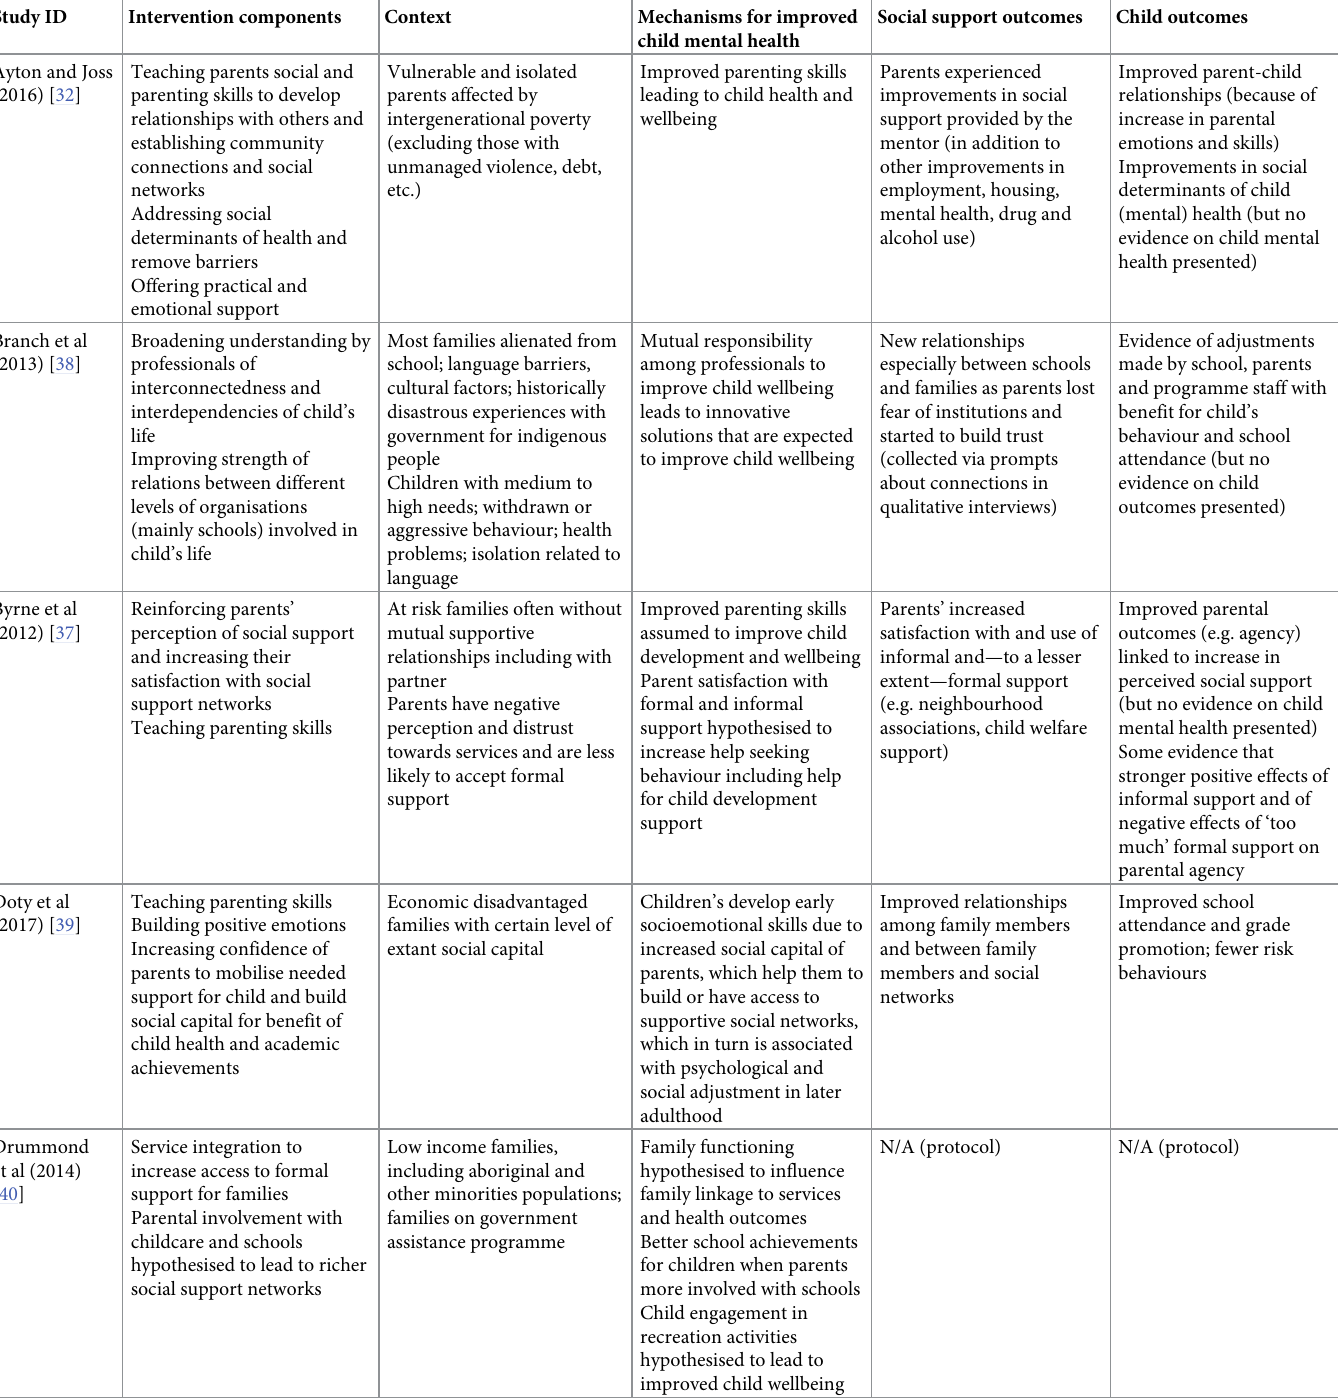
Table 2. Information about programme theories and findings for included studies concerned with children (3 to 9